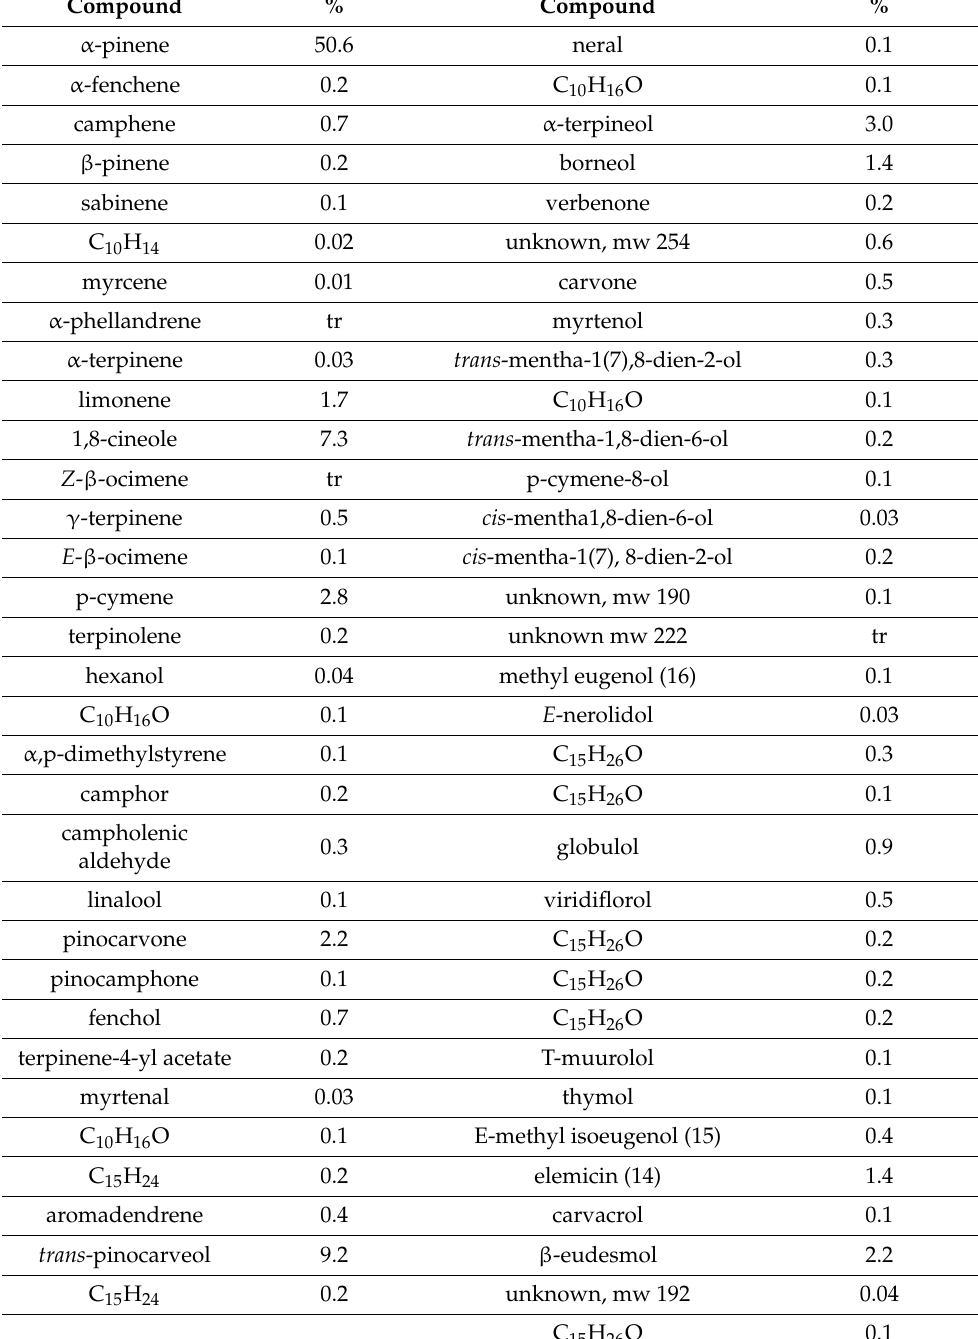
Table 9. Compounds identified in the leaf oil of Backhousia leptopetala